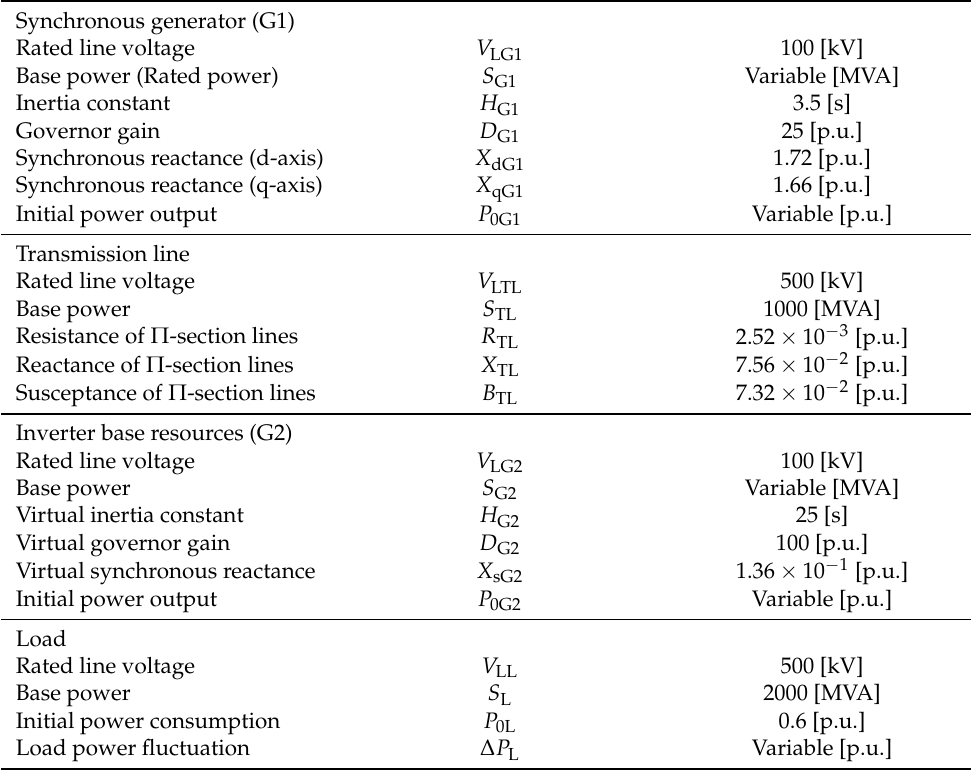
Figure 6. Turbine and governor model of the synchronous generator. This figure was created from [40]. The speed of the valve is mechanically limited and cannot be controlled at a fast response such as an IBR. Table 3. Parameters of the two-generator system